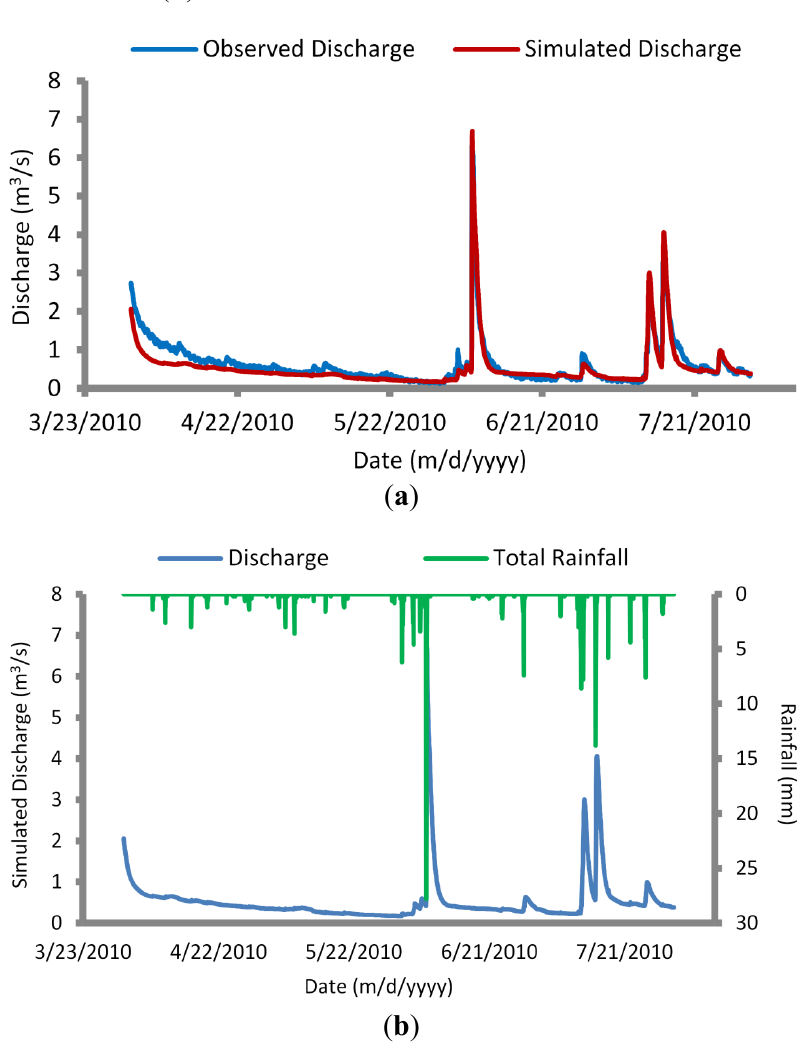
Figure 5. Simulated versus observed discharge values for validated hydrodynamic (HD) module (1 April–31 July 2010) ( a ); and observed rainfall versus simulated discharge values for validated HD module ( b